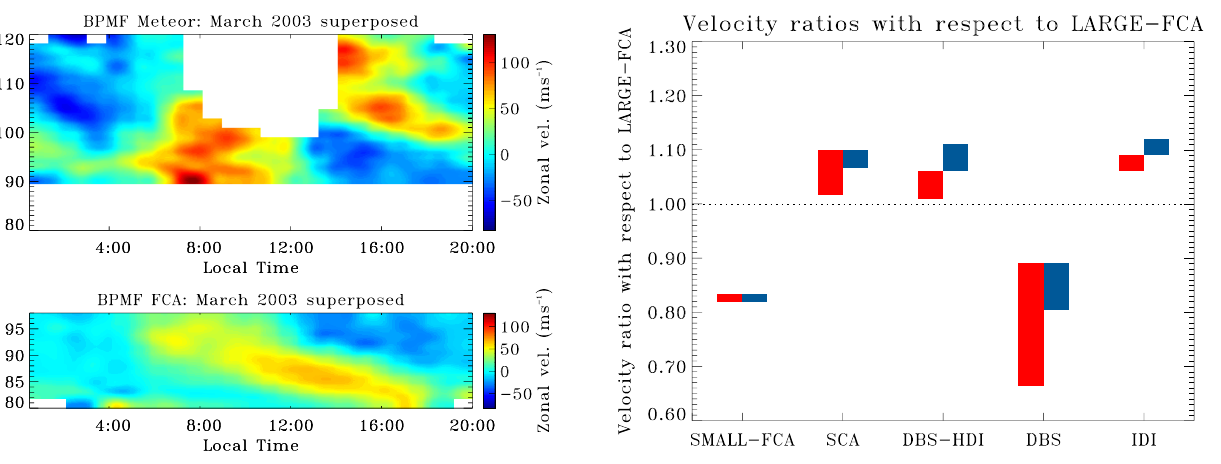
Fig. 9. Superposed velocities estimated using meteor (top) and full correlation analysis (bottom) for March 2003.